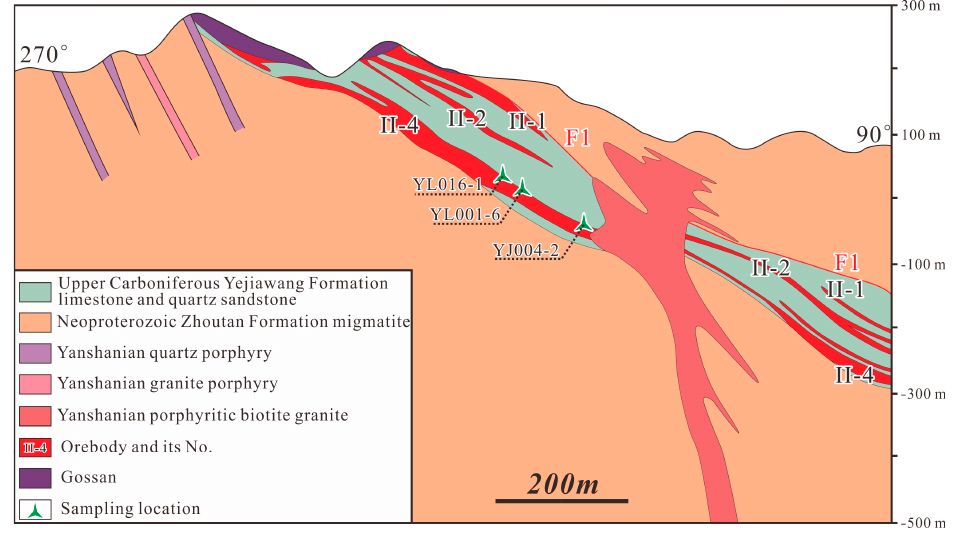
Figure 3. Representative cross-section of the Yongping Cu deposit (modified after [27]).